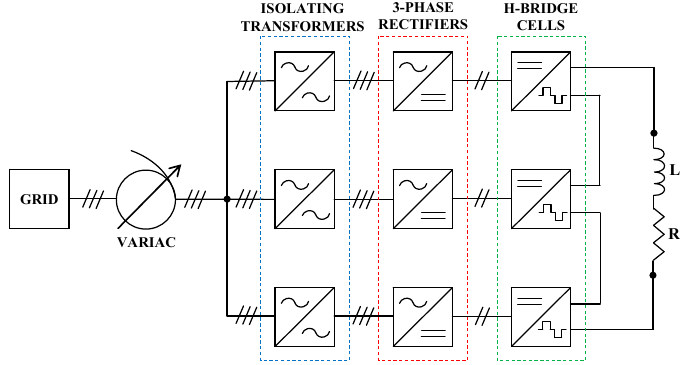
Figure 8. Circuit scheme of the experimental setup.